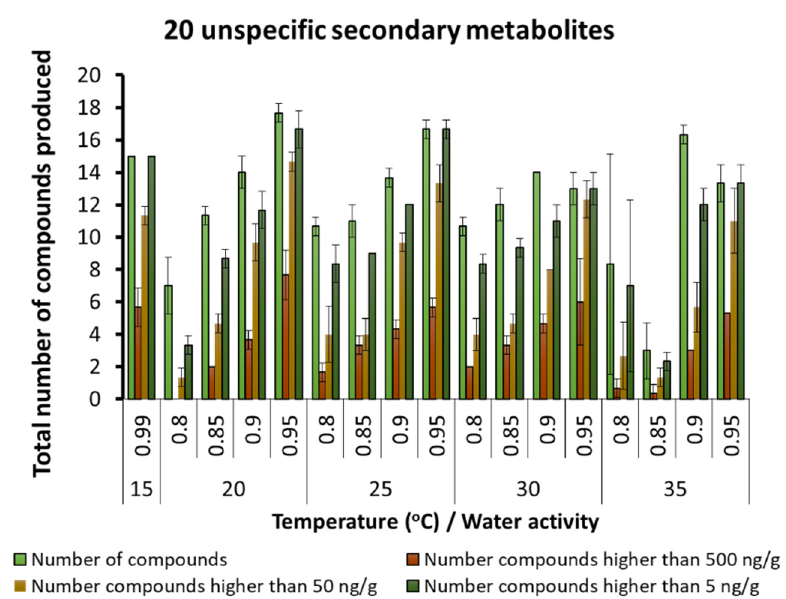
Figure 7. Unspecified secondary metabolites detected in the maize samples under different temperature × water activity conditions. Bars represent the Standard Error of the mean. Note change in scale to 0–20 metabolites.